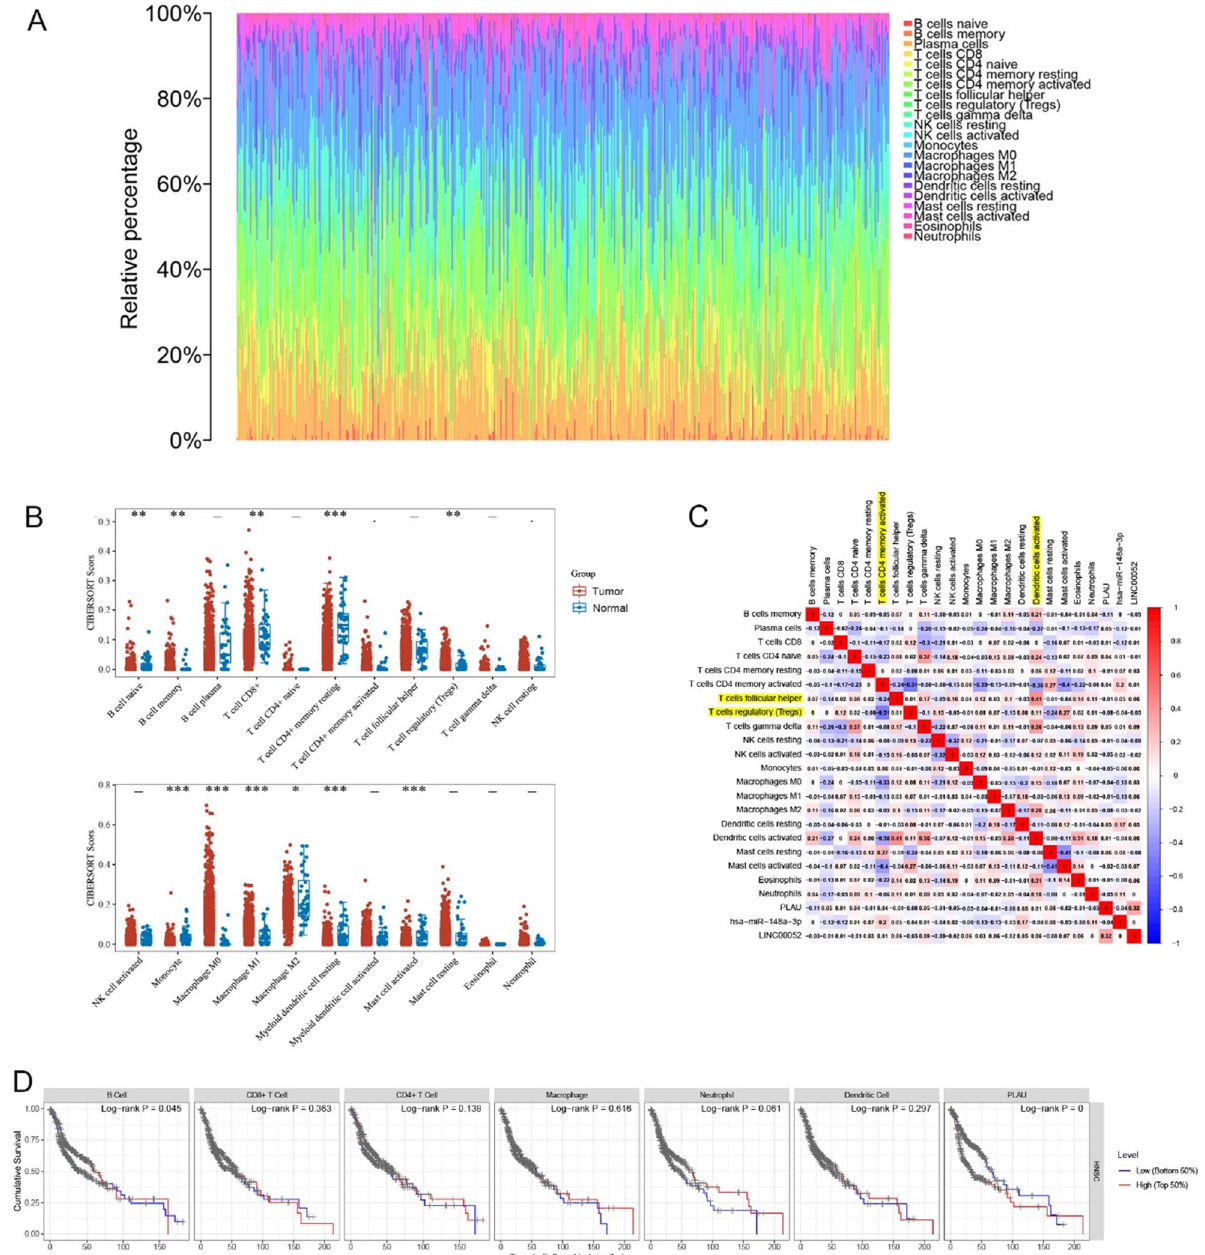
Figure 9. Analysis of immune infiltration. ( A ) The composition of 22 immune cells was estimated by CIBERSORT in HNSCC. ( B ) Difference in the proportions of 22 immune cells between normal and tumor tissues (*p < 0.05, **p < 0.01, ***p < 0.001). ( C ) The correlation index among immune cells and ceRNA in HNSCC. Positive and negative correlations are represented by the red and blue colors, respectively. The degree of correlation index is represented by the color depth. The yellow color shows the genes with the highest positive and negative correlations. ( D ) Kaplan–Meier plots were used to analyze the immune infiltration and overall survival rate of